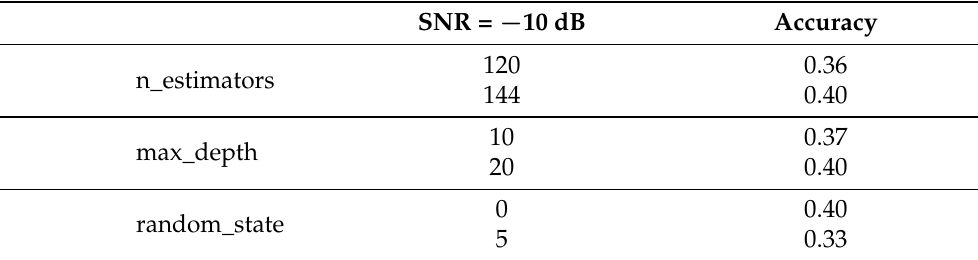
Table 3. The accuracy of RF model parameters and related